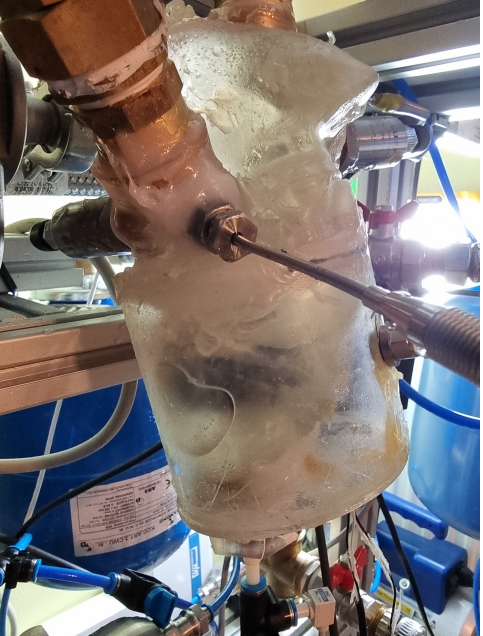
Figure 5. Flexible left heart model in a transparent cylinder—experimental